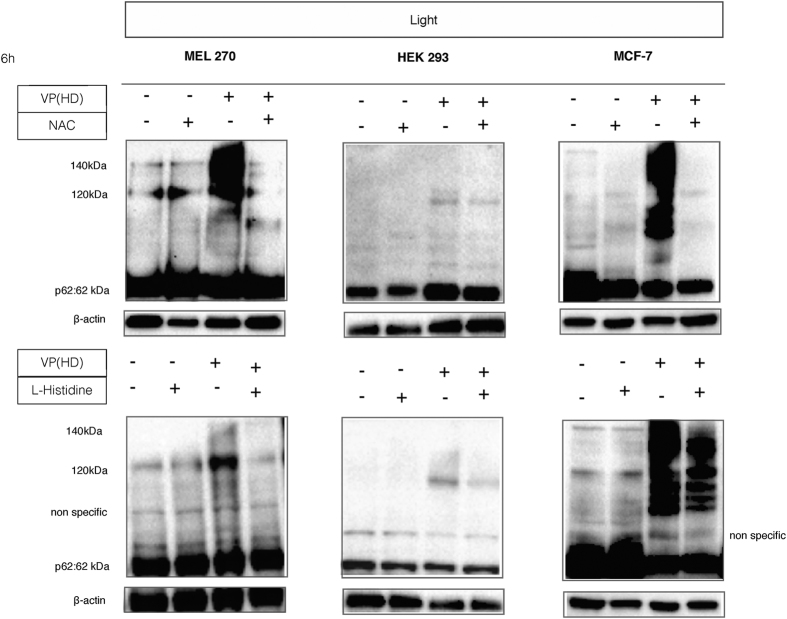
Presence of N-Acetyl Cysteine (NAC) or L-histidine in cellular homogenates decreases the formation of VP induced cross-linked oligomers and HMWC.Western-blot analysis of p62 in protein extracts from cells never exposed to VP in culture. Cellular homogenates were pre-treated with N-Acetylecysteine- NAC (1 mM) or L-histidine (7.5 mM) 30 min before incubation with high dose (HD- 7.5 μg/ml) Verteporfin. Extracts pretreated with NAC or L-Histidine demonstrated decrease or no formation of VP induced cross-linked oligomers and HMWC compared to controls. (Multiple exposures are provided in Supplemental Information).